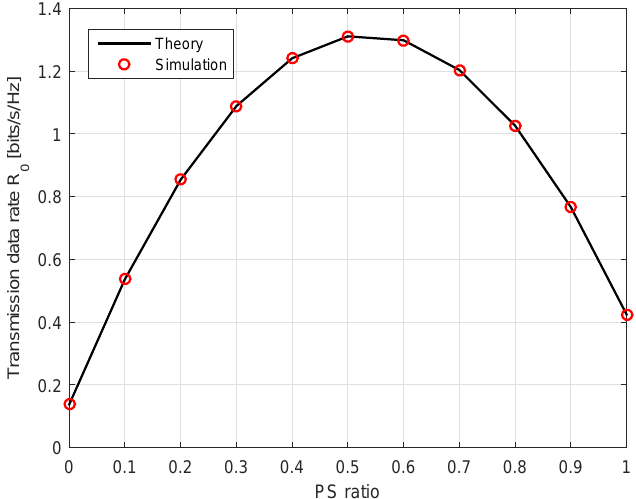
Figure 2. The relationship between the power splitting (PS) ratio and the transmission